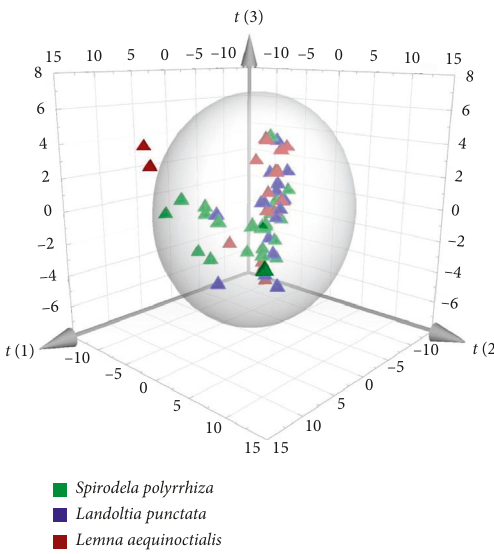
Figure 2: Three-dimensional score plot of principle component analysis (PCA) based on the content of free amino